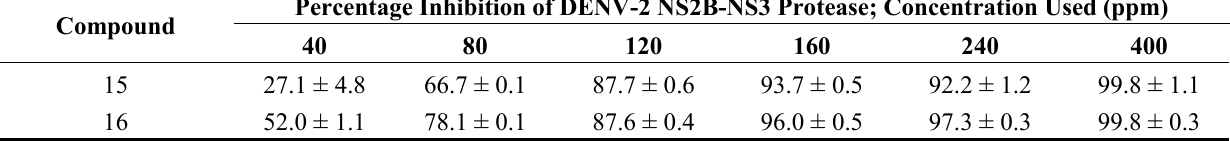
Table 3. Percentage inhibition of DENV-2 NS2B-NS3 virus protease cleavage a of compounds 15 and 16